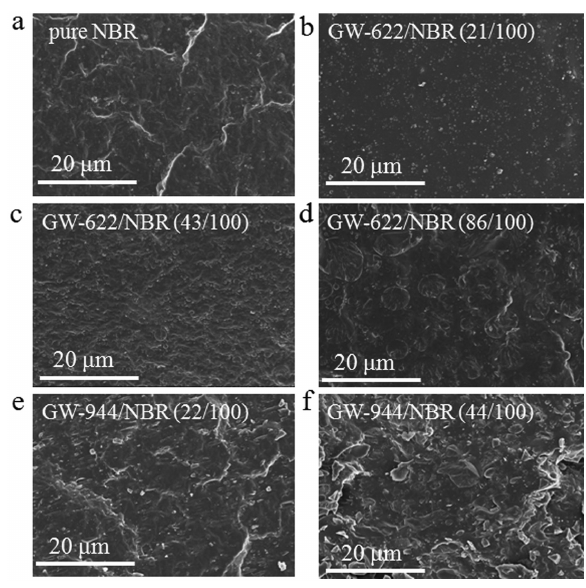
amine/NBR Figure 3: SEM image of hindered amine/NBR